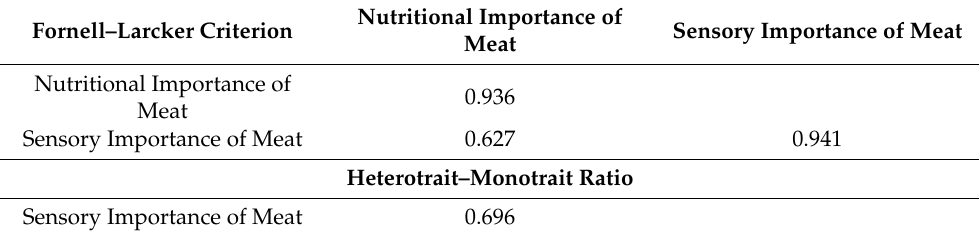
Table 4. Fornell–Larcker Criterion, and Heterotrait–Monotrait